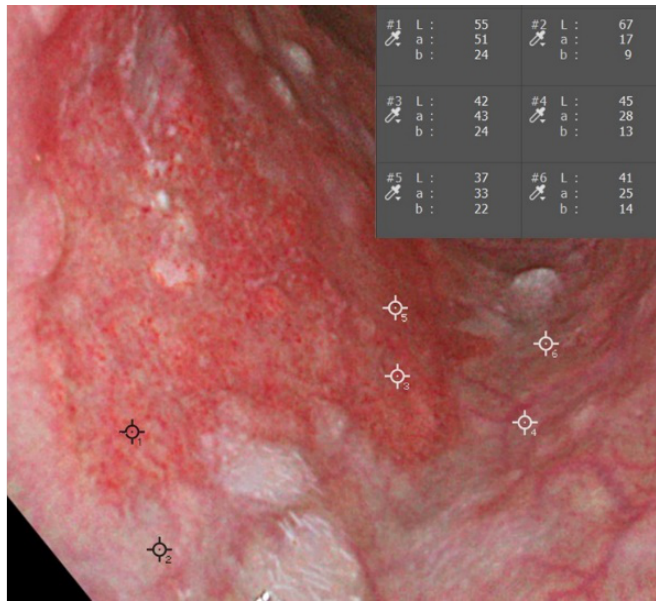
Figure 3. Color analysis was conducted using computer software. A region of interest (ROI) was selected in the lesion (#1) and surrounding mucosa (#2) on the endoscopic image. The color value based on the L*a*b* color space was automatically calculated. We selected three pairs of ROIs for each